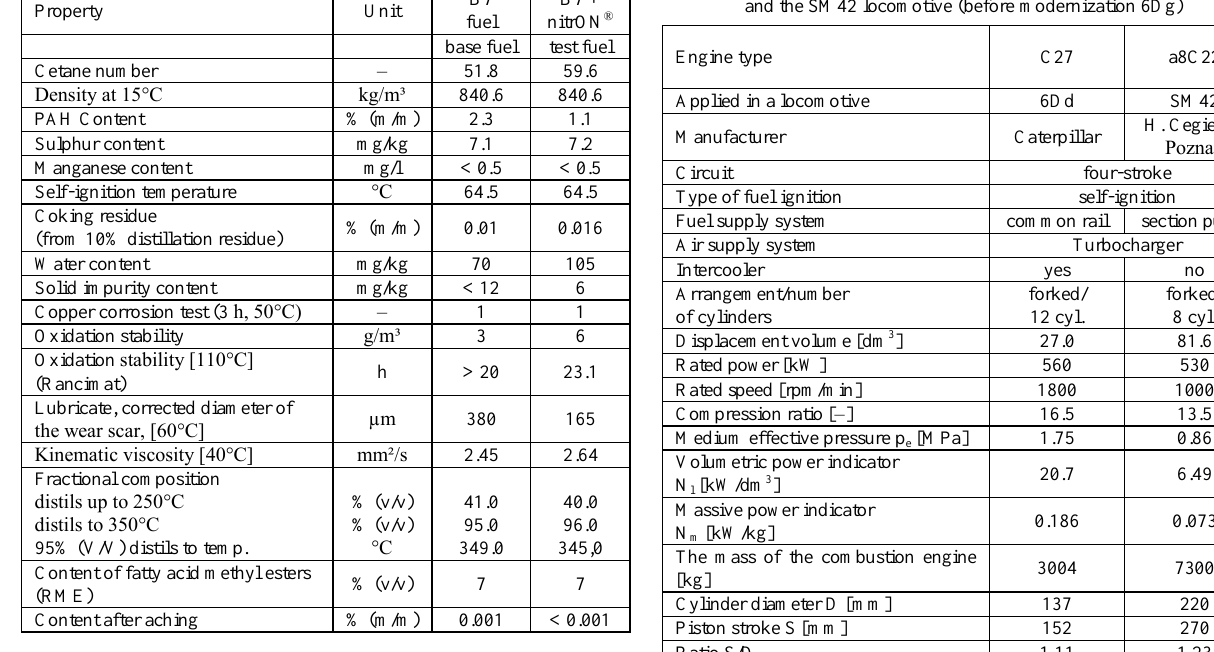
Table 2. Parameters of combustion engines used in the 6Dg locomotive and the SM42 locomotive (before modernization